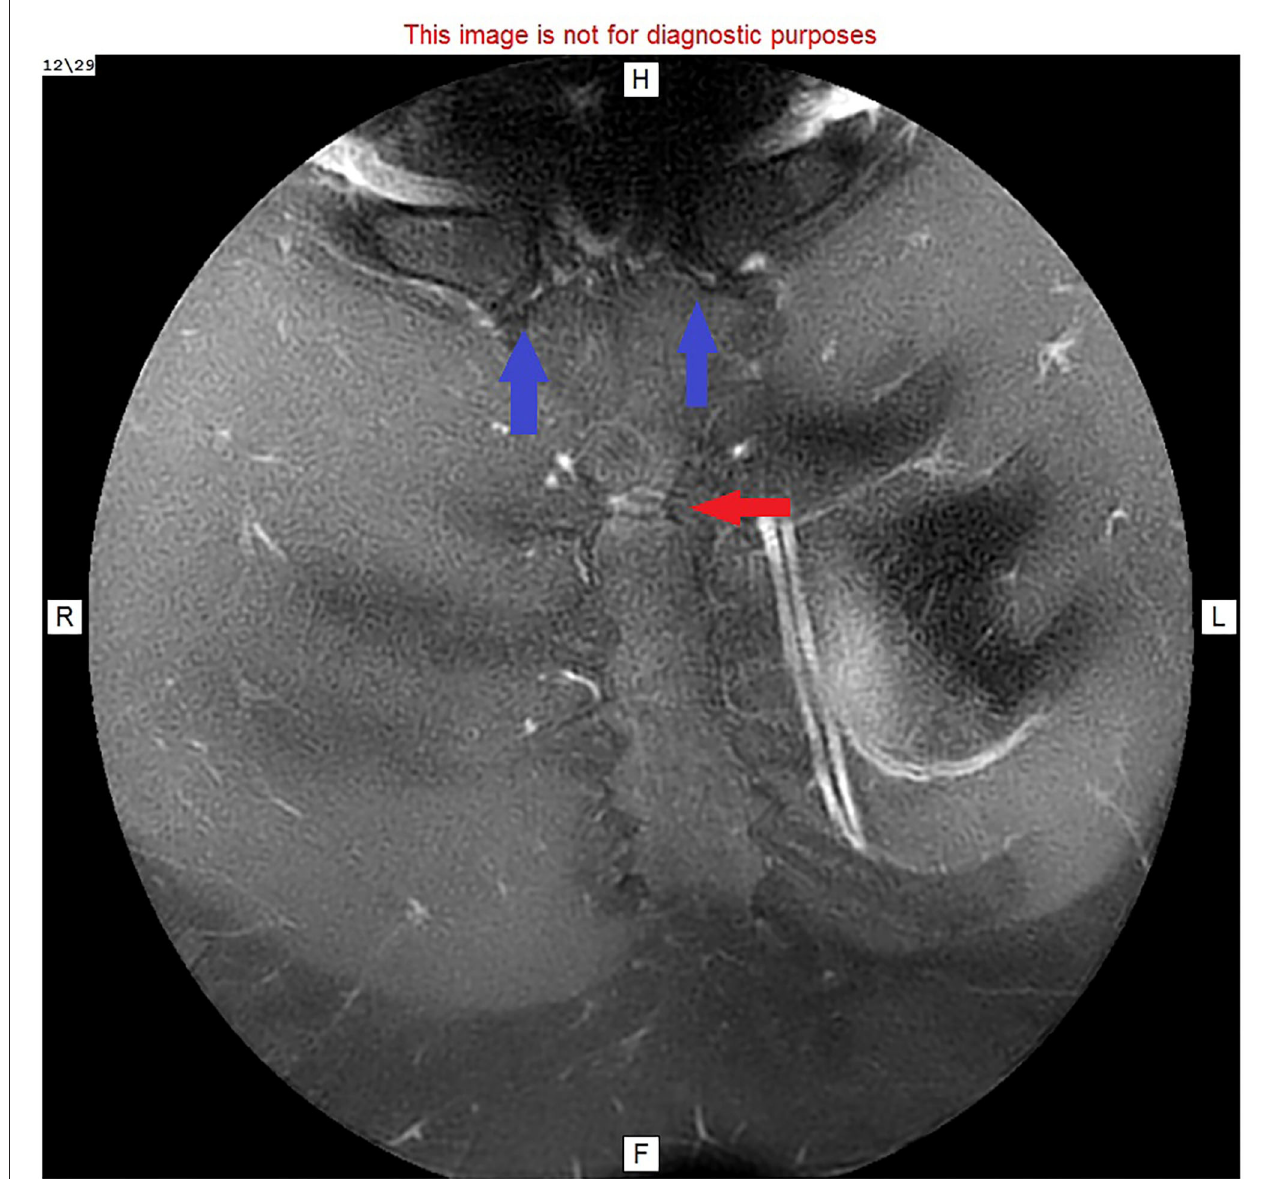
FIGURE 4 | MRI image: T1 with faset and gadolinium contrast, cranial view, showing enhanced manubriosternal joint (red arrow) and normal sternoclavicular joints (blue arrows).